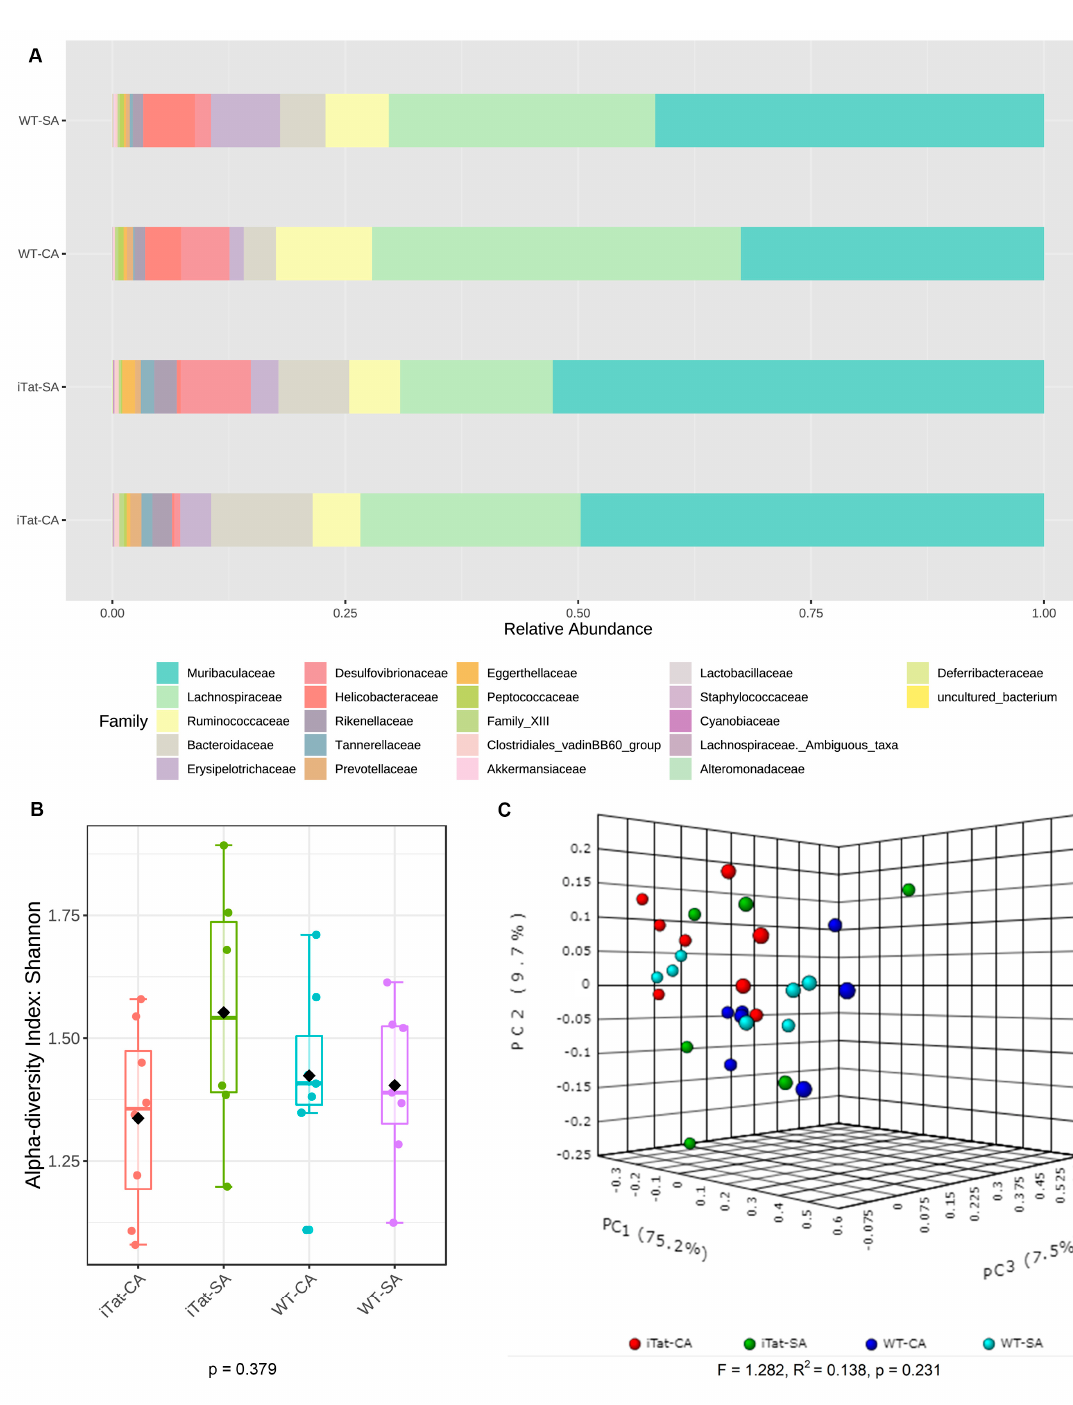
Figure 7. Effects of Tat expression and cocaine exposure on microbial abundance and diversity in the gut of 12-month male mice. ( A ). Relative abundance (%) of top 22 families of gut microbiota in four experimental groups, WT-SA, WT-CA, iTat-SA, and iTat-CA, were presented as a stacked bar plot. ( B ). Shannon index was calculated to determine α -diversity of gut microbiota in four experimental groups WT-SA, WT-CA. iTat-SA, and iTat-CA, presented as a box plot, and analyzed using the Kruskal–Wallis test. The error bars were standard derivation (SD). ( C ). Bray–Curtis dissimilarity was calculated to determine β -diversity, presented as a PCoA plot, and analyzed using PERMANOVA. The percentage variations in the plotted principal component were indicated on the axes.